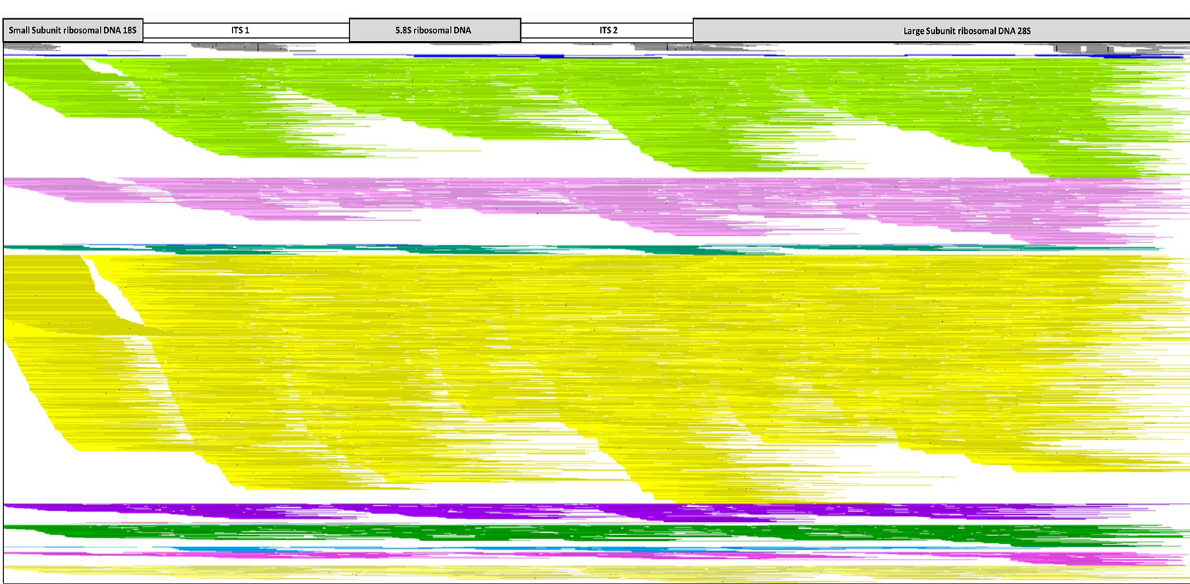
Fig 6. Vision 2.6.24 image of 13 NuGen Ovation 1 ultralow system V2 VPRI 18536 DNA extraction protocol libraries mapped to P . leucotricha ITS (GenBank accession no. KX842350.1) including P . tridactyla as an outgroup for comparison. Continuous unbroken lines represent sequence reads that completely align to the reference sequence. Gaps in the alignment indicates no mapping sequence reads, and SNPs between the mapped read and the reference are represented as black bars. Colour code: Grey- P . tridactyla , Dark Blue- CheX (Chelex 1 100), Light Green- InuP (innuPrep Plant DNA), Light Pink- SDS (sodium dodecyl sulphate), Blue- EznS (E.Z.N.A. 1 SP Plant), Green- DnaZ (DNAzol ™ ), Yellow- EznF (E.Z.N.A. 1 Forensic DNA), Purple- DneP (Qiagen DNeasy 1 Plant), Red- IspC (Isolate II Plant DNA Lysis buffer PA1 C), Light Blue- IspS (Isolate II Plant DNA Lysis buffer PA2 S), Dark Green- WizG (Wizard 1 Genomic DNA Purification), Light Blue- EznP (E.Z.N.A. 1 Plant), Dark Pink- CTAB (Cetyl trimethyl ammonium bromide) and Light Yellow- DneP+ (Qiagen DNeasy 1 Plant plus PTB).